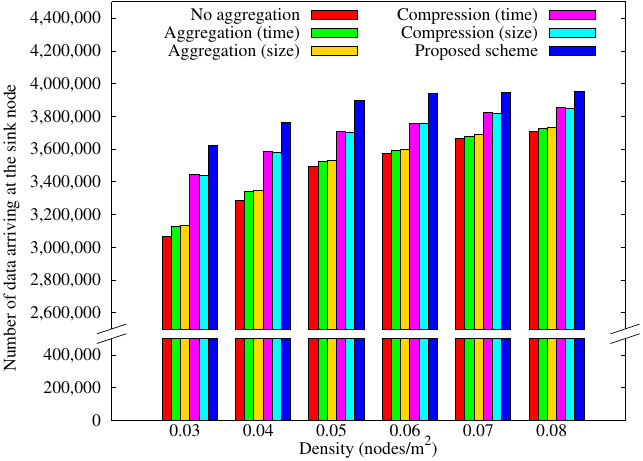
Figure 9. Change in the amount of data arriving at the sink node with node